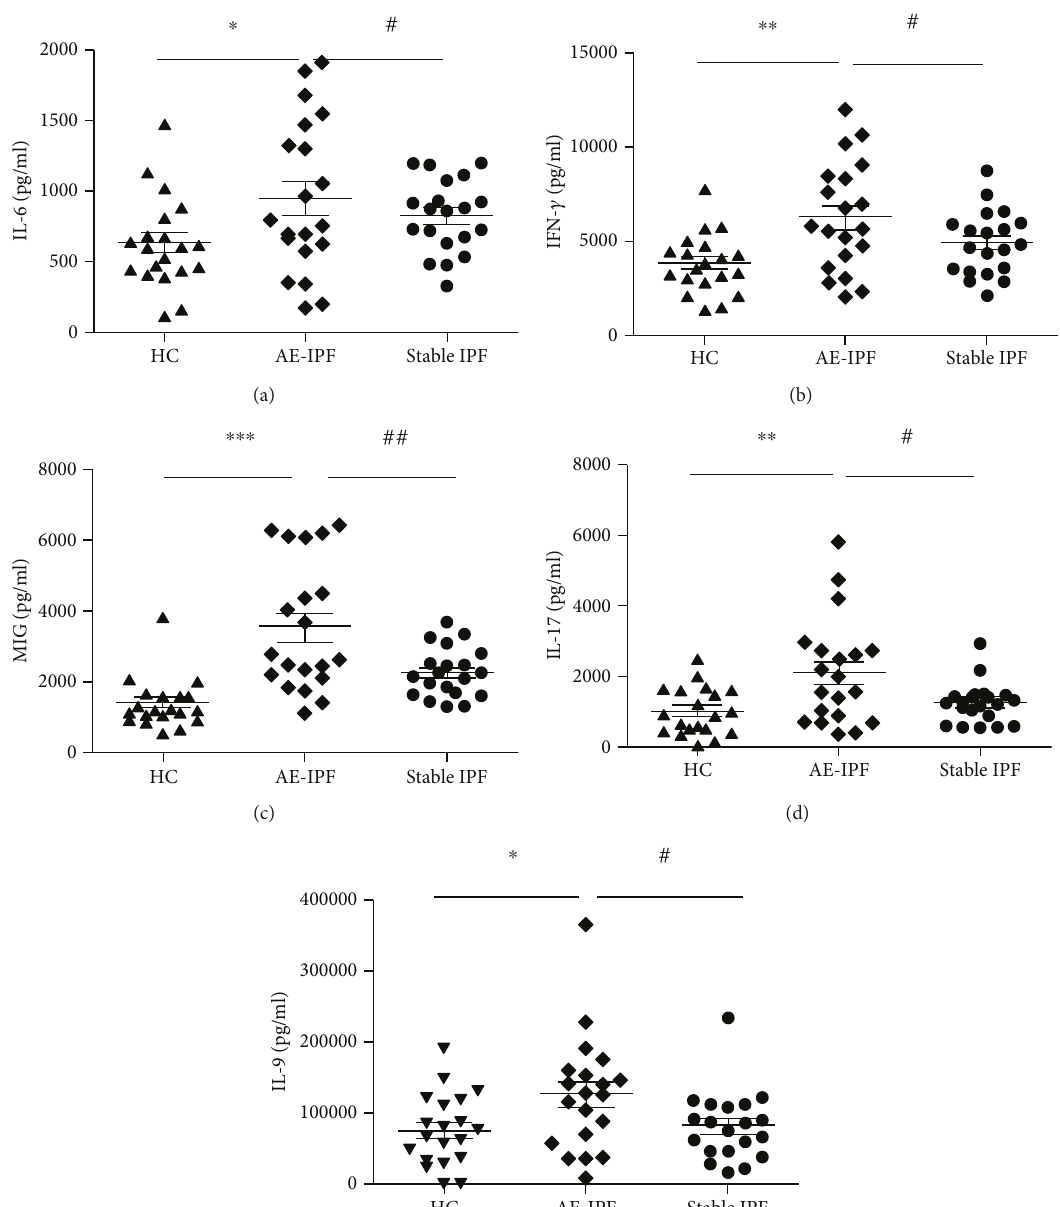
Figure 3: Antimicrobial in fl ammatory cytokines in AE-IPF. Serum of 40 IPF patients (20 AE-IPF and 20 stable IPF) and 20 controls was examined with protein microarray analysis. When compared with controls and stable IPF patients, AE-IPF patients showed signi fi cant increases in the levels of IL-6, IFN- γ , MIG, IL-17, and IL-9. One-way ANOVA followed by Tukey ’ s post hoc test was used to compare three groups. ∗ p < 0 05 , ∗∗ p < 0 01 , ∗∗∗ p < 0 001 AE IPF vs. controls. # p < 0 05 , ## p < 0 01 , ### p < 0 001 AE IPF vs. stable